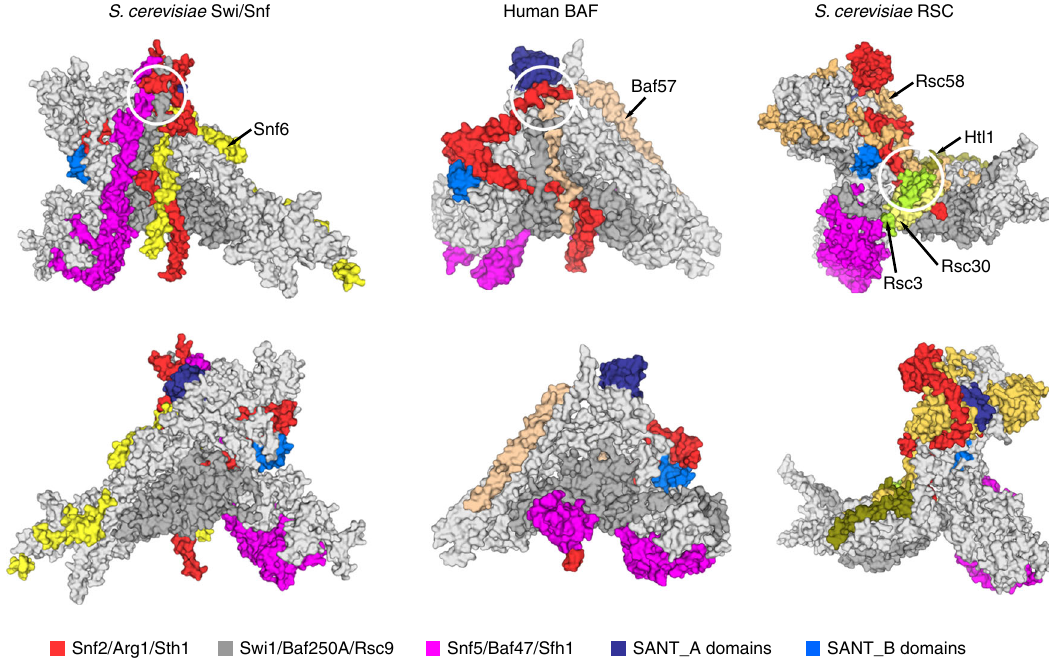
Fig. 5 Structural comparison of base modules from Swi/Snf, BAF, and RSC complexes. The front (above) and back (bellow) views are presented in surface model with the multi-subunit junction circled by white lines. The protein elements are color coded and tabulated on the